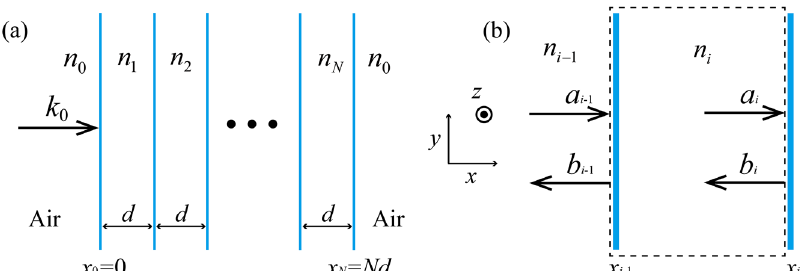
Figure 1: (Color online) (a) The 1D random system composed of random dielectric layers (white) with gain/lossy coatings (blue). The whole system is embedded in air.(b)Theschematicofwavepropagations inside the 1D random system. The black dashed line indicates the choice of the i -th scattering element. 1D,